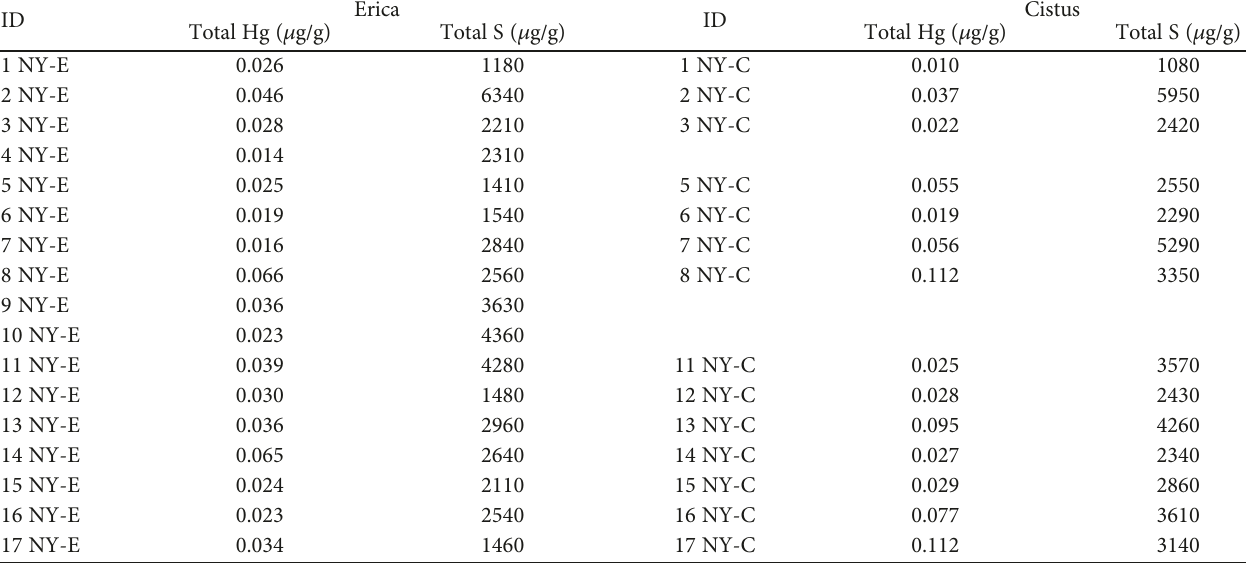
Table 3: Hg and S concentrations in plant leaves collected in the Lakki Pain, Nisyros.